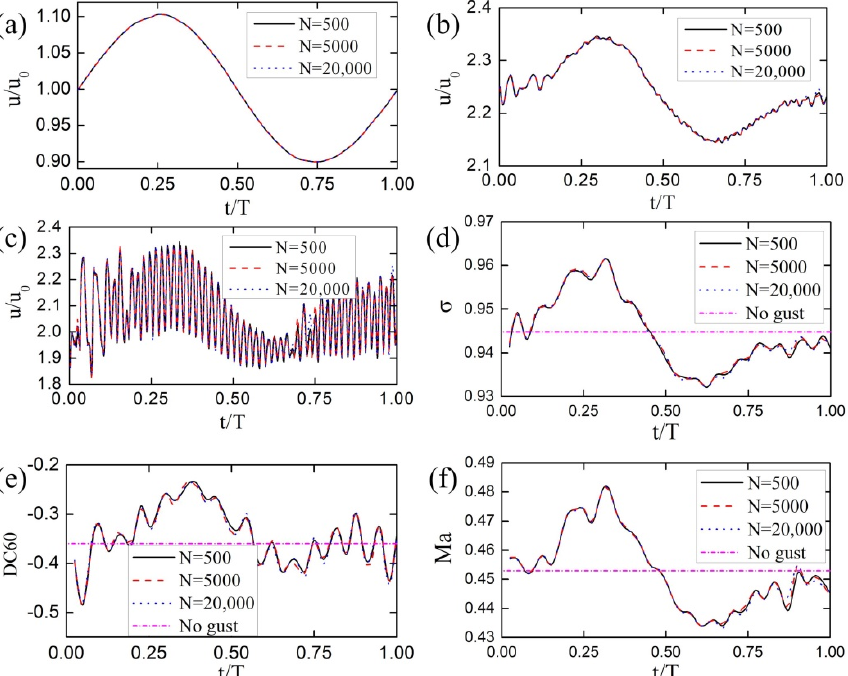
Figure 18. Effects of the number of gust discretization intervals for a full-period gust, N, on the CFD results of the gust velocity at three probe locations in the symmetry plane ( a ) in the farfield, ( b ) at the middle of the entrance of the diffuser and ( c ) at the middle of the AIP position; Effects of N on ( d ) the total pressure recovery, ( e ) circumferential distortion and ( f ) outlet Mach number at the AIP. The simulated gust frequency is f = 50 Hz and amplitude (cid:101) u g = 8 m/s.